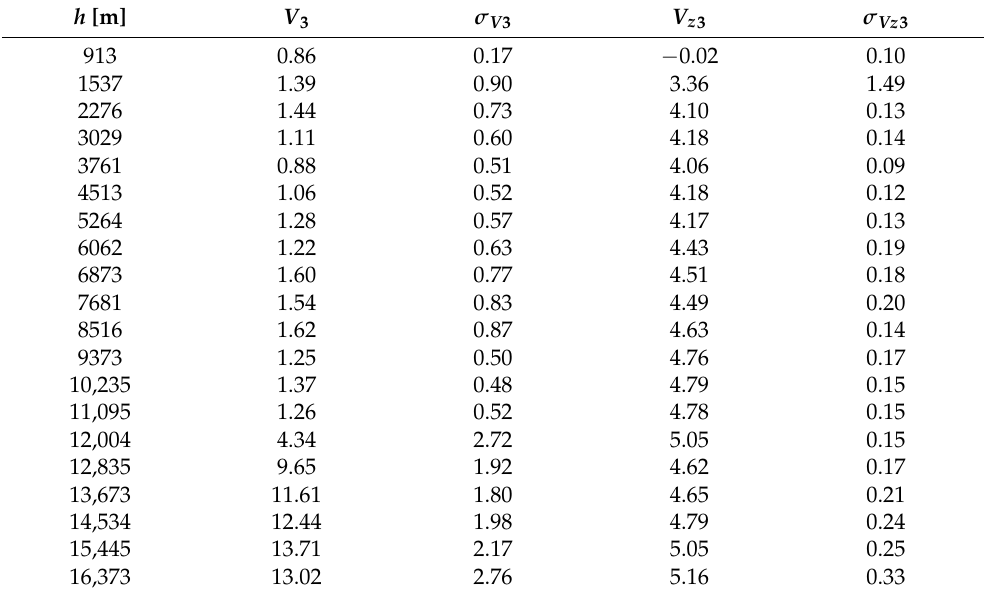
Table 3. 3-min. average horizontal and vertical wind speeds, V 3 and V z 3 , and standard deviations, σ V 3 and σ Vz 3 .These values were calculated in the 3-min. lapse before the corresponding altitude).